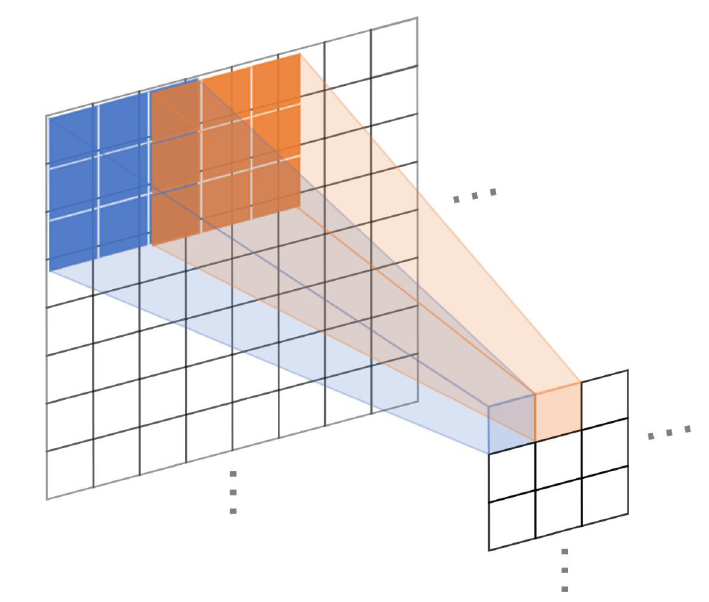
Figure 5. 3 × 3 overlap pooling